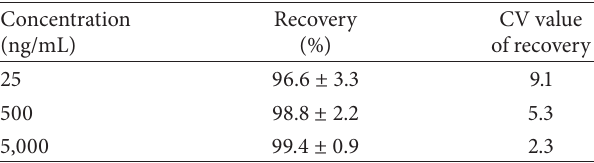
Table 2: Recovery of propofol in human plasma ( 𝑛 = 6 ).